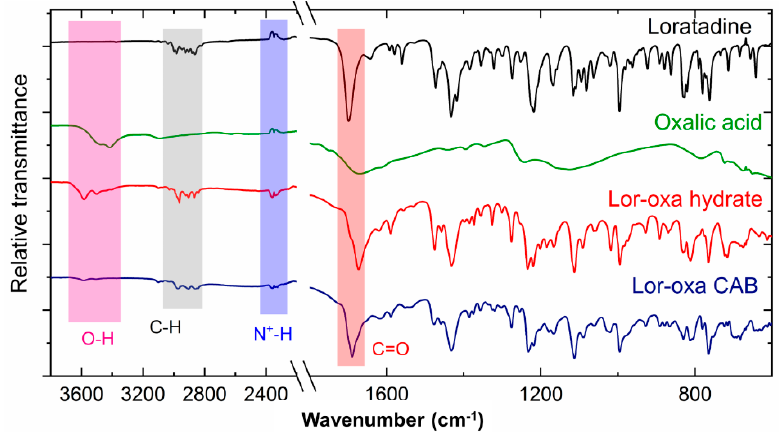
Figure 6. Fourier transform infrared (FT-IR) spectra of Lor, Oxa, Lor-Oxa CAB, and Lor-Oxa hydrate.